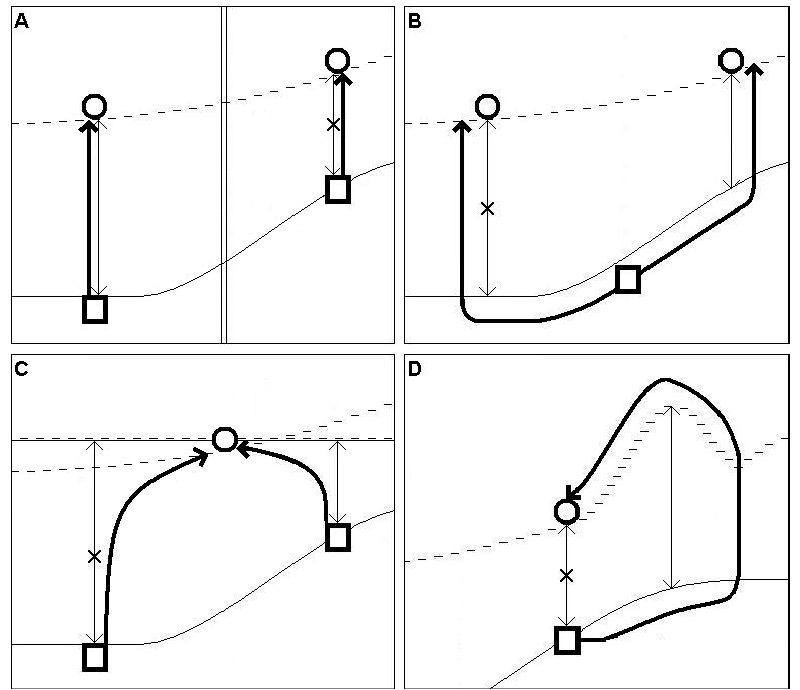
Figure 2. Multiple track structure of the supposed migration during the HTM-period; Explanation for subfigures ( A – D ) is provided in the main text. Symbols: square = closest recent southern occurrence to the recent isolation; circle = recent northernmost, isolated occurrence; solid line = northern edge of suitable habitats consisting of sporadic or continuous recent occurrences; broken line = hypothetic, supposed minimum of the northernmost expansion of the taxa during the HTM period (this could expand further north but without remnant occurrences poleward this cannot be judged); thin arrows with arrowheads on both ends = (N-SD), distance between the recent isolated and continuous occurrences, or distance between the continuous occurrences and the northernmost part of the suitable habitat-belt ( D ); thick, simple arrows = hypothetical tracks of the taxa during the HTM period; double solid lines = barrier of migration ( A ); double solid-broken line = added line ( C ). Supplementary Table S2 shows the alternative tracks for these five species and the supplementary text before the table describes the tracks by names of geographical sites.